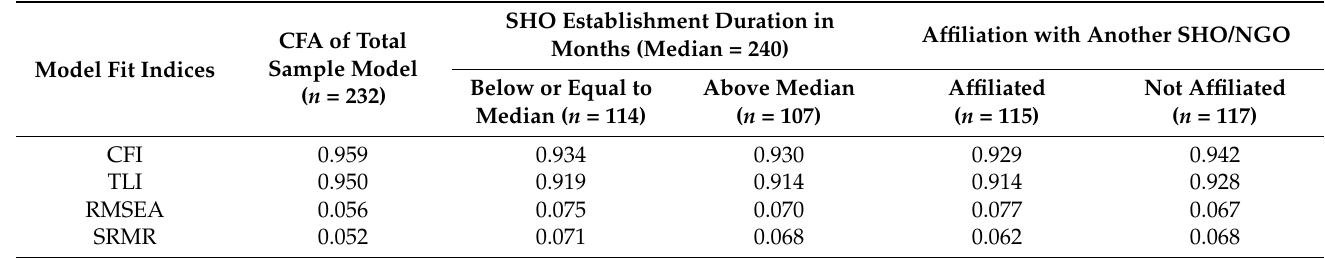
Table 2. CFA goodness of fit for total sample and subgroup samples.